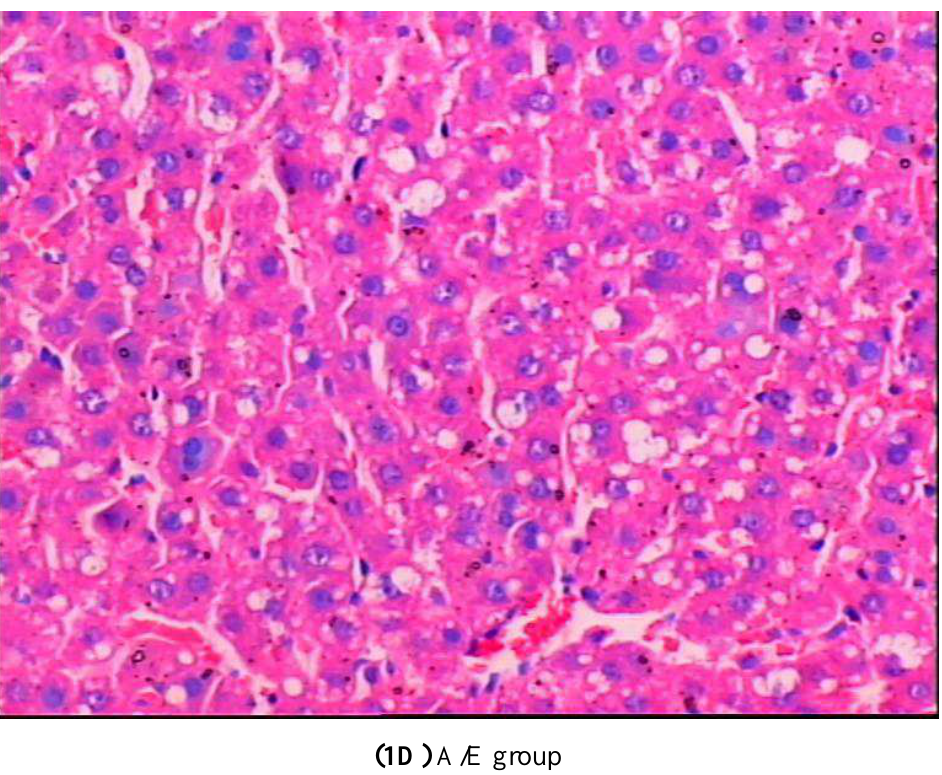
Table3 . Serum ALT and TNF- α levels, plasma endotoxin levels and liver MDA contents in